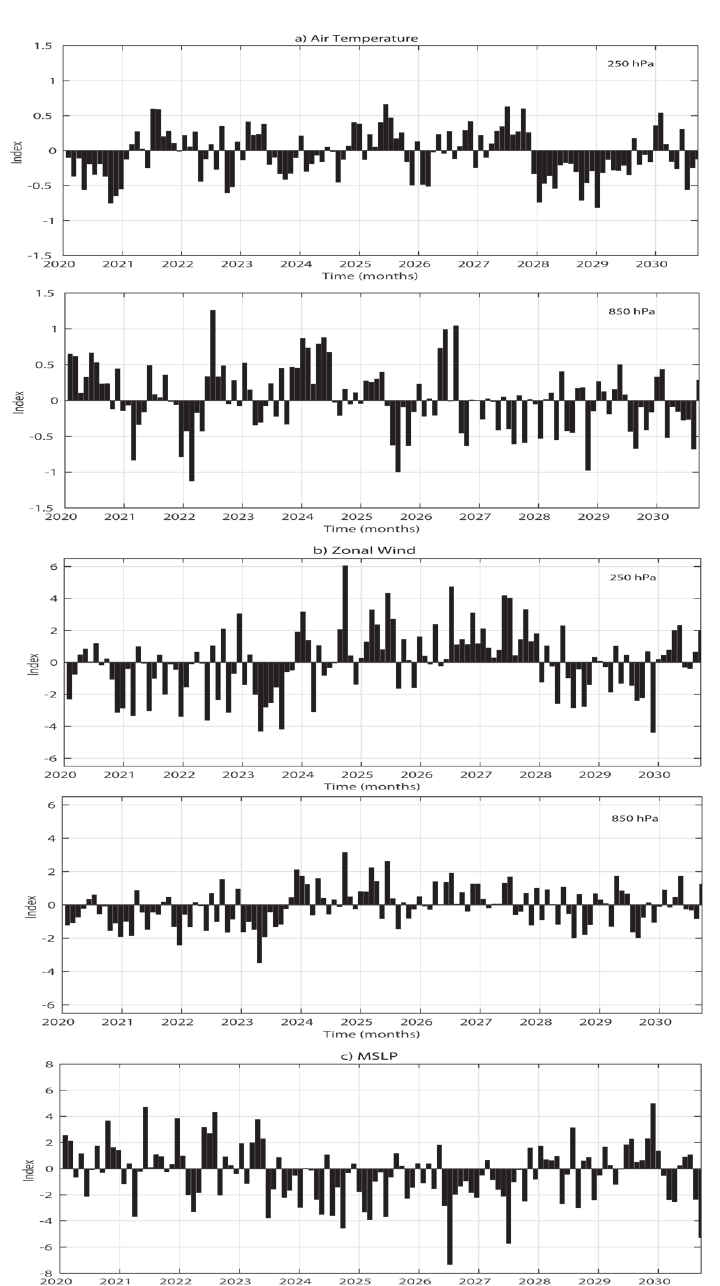
Figure 6. Differences between layermax- layerctl experiments at middle (40°S) and high (65°S) latitudes for: a) 250 hPa and 850 hPa air temperature; b) 250 hPa and 850 hPa zonal mean wind and c) MSLP during the whole period of CM2.1 model